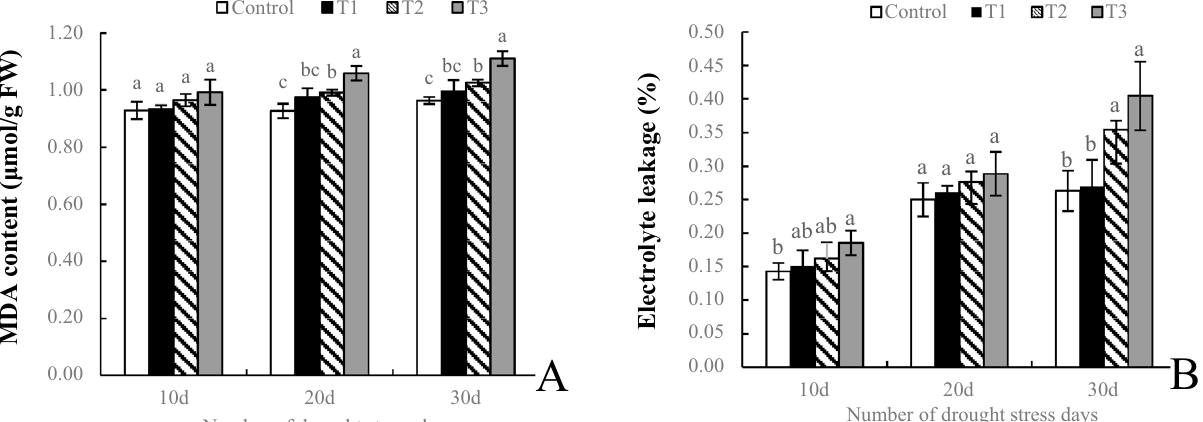
Figure 3. Effects of drought stress on membrane lipid peroxidation of Phedimus aizoon L. Note : MDA content ( A ), electrolyte leakage ( B ).